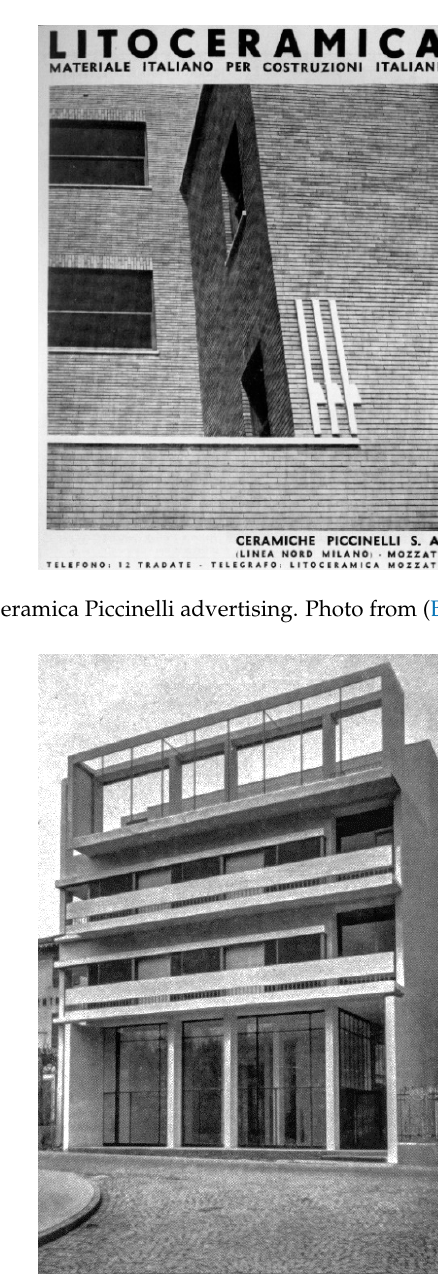
Figure 2. Rent House in Cernobbio of Cesare Cattaneo (1938–1939). Photo from (Sartoris 1957, p. 272).